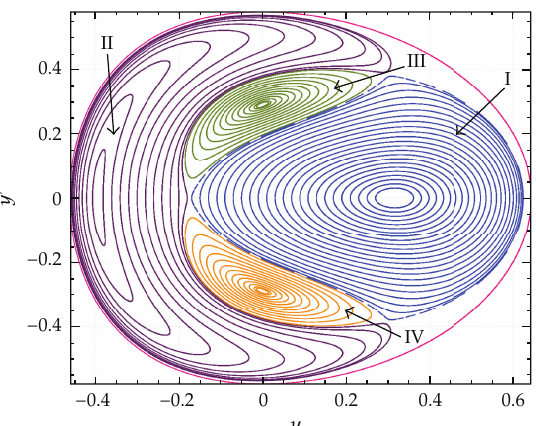
Figure 1: Poincar´e surface of section at E (cid:7) 0 . 166666 (cid:5) in fifth-order Hamiltonian (cid:6) . We observe four families of closed invariants: I (cid:5) blue (cid:6) , II (cid:5) purple (cid:6) , III (cid:5) green (cid:6) , and IV (cid:5) orange (cid:6) . The surrounding curve is the ZCV (cid:5) Zero Velocity Curve (cid:6)